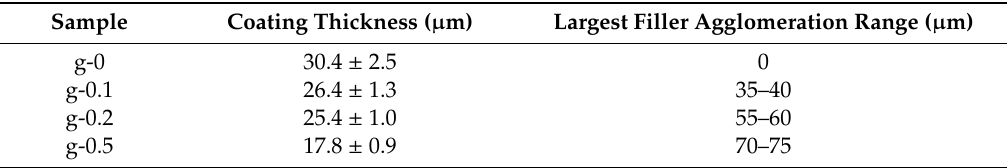
Table 3. Coating thickness, with relative largest filler agglomeration